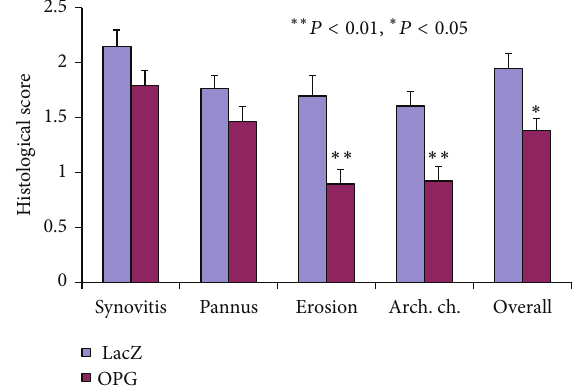
Figure 4: Summary of histological evaluation of arthritic paws with or without OPG gene transfer. Five categories are assessed on each paw section in a blinded fashion. OPG gene modification signifi- cantly ameliorate the disease progress, especially in bone/cartilage erosion and architecture